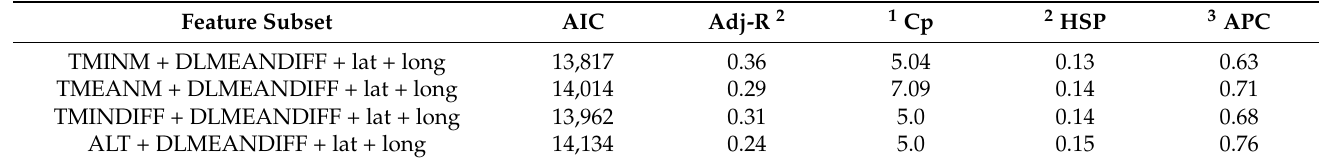
Table 4. Best subset of features used as predictors to build a soybean time to maturity (TTM) model. Feature selection based on stepwise forward